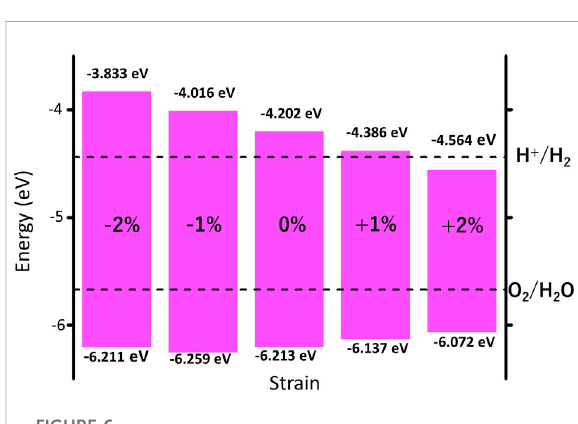
FIGURE 6 Strain effects on band edge positions of MoWS 4 monolayer with respect to the vacuum level (0 eV). The redox potentials of water splitting at pH = 0 are shown for